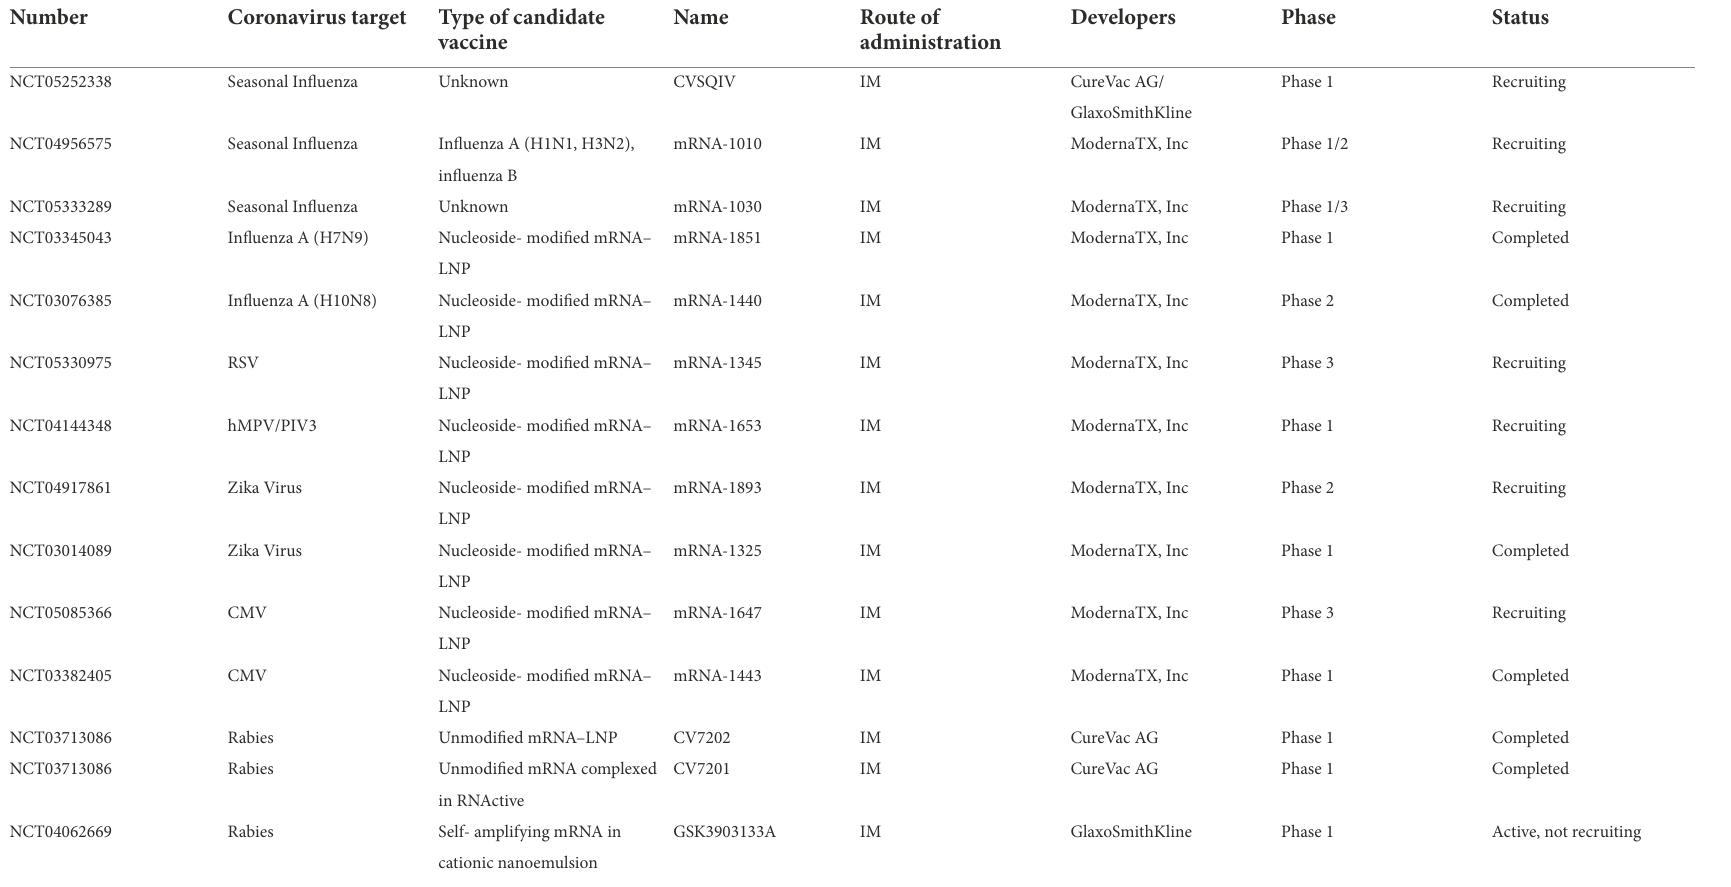
TABLE 3 Clinical trials of mRNA vaccines for infectious diseases other than